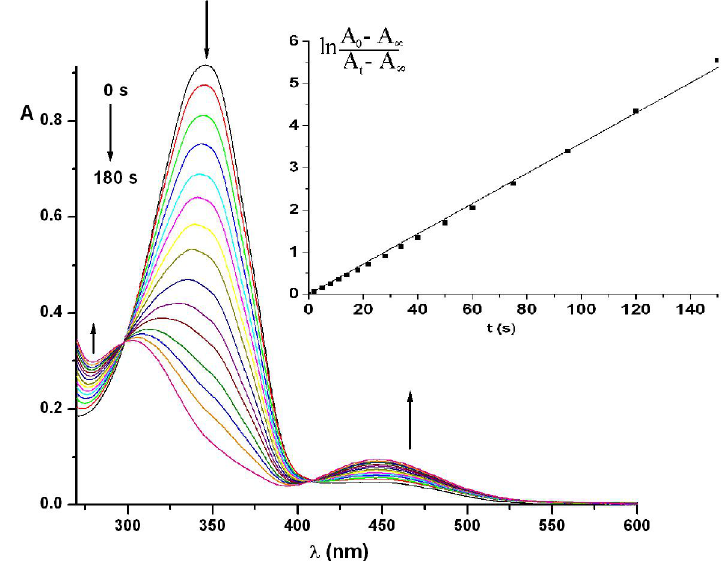
Figure 2. Dependence of UV-Vis absorption spectra of ABM 2 in N , N -dimethylformamide (DMF) solution on UV irradiation. Inset shows a first-order plot for trans-cis photoisomerization. Arrows indicate the directional changes of the